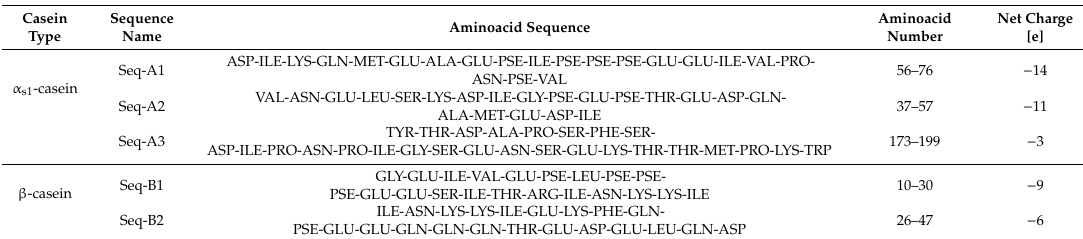
Table 1. Sequences of aminoacids representing fragments of casein chain used in the molecular dynamics simulations.